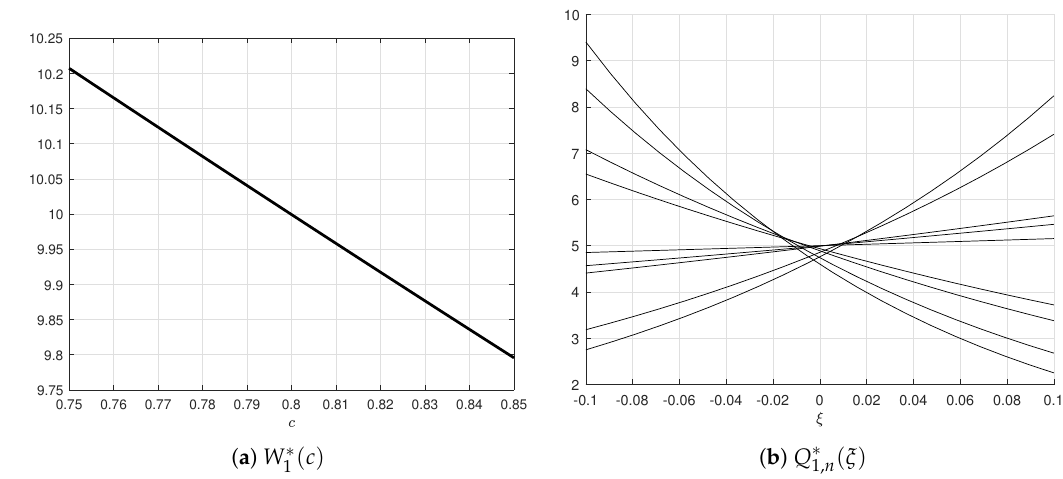
Figure 2. PDFs of the parameters and noises for i = 1.